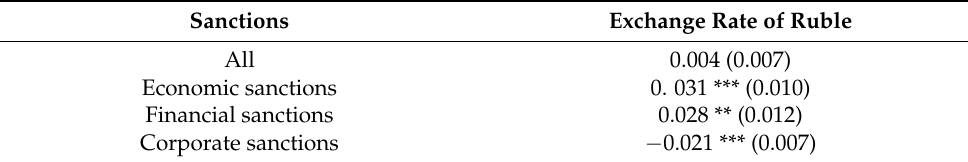
Table 14. Coefficients of Sanctions as an Independent Exogenous Variable in the VAR